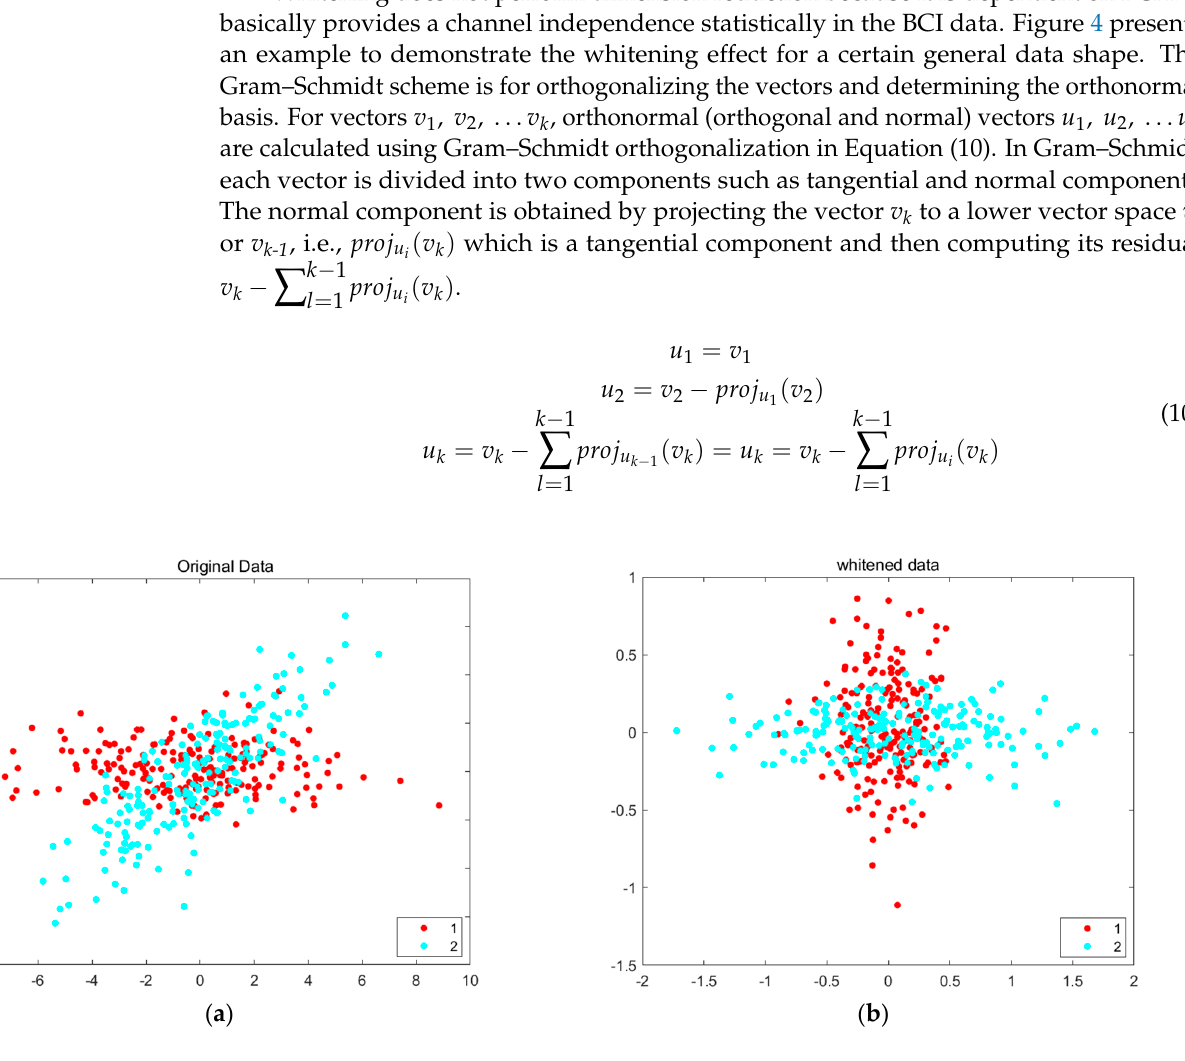
Table 1. Accuracy results of trial EFA.